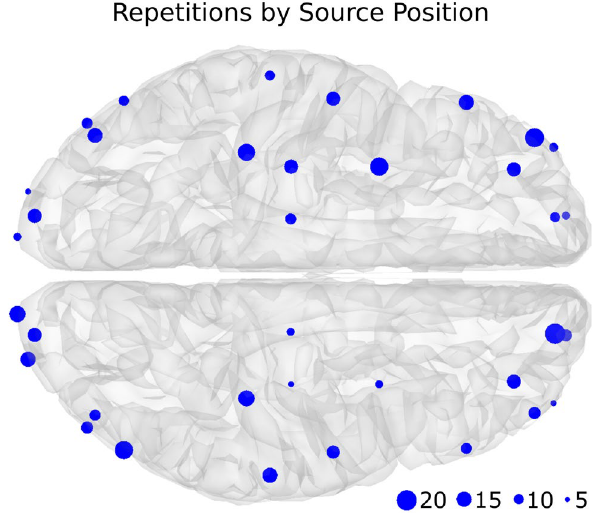
Figure 3. Repetition by source position. Blue circles represent where the simulated activity was located and their diameter represents the number of times that position was selected in the 150 EEG trials. It can be seen that each area (occipital lobe, sensory-motor cortex, and frontal lobe) has six locations per hemisphere.